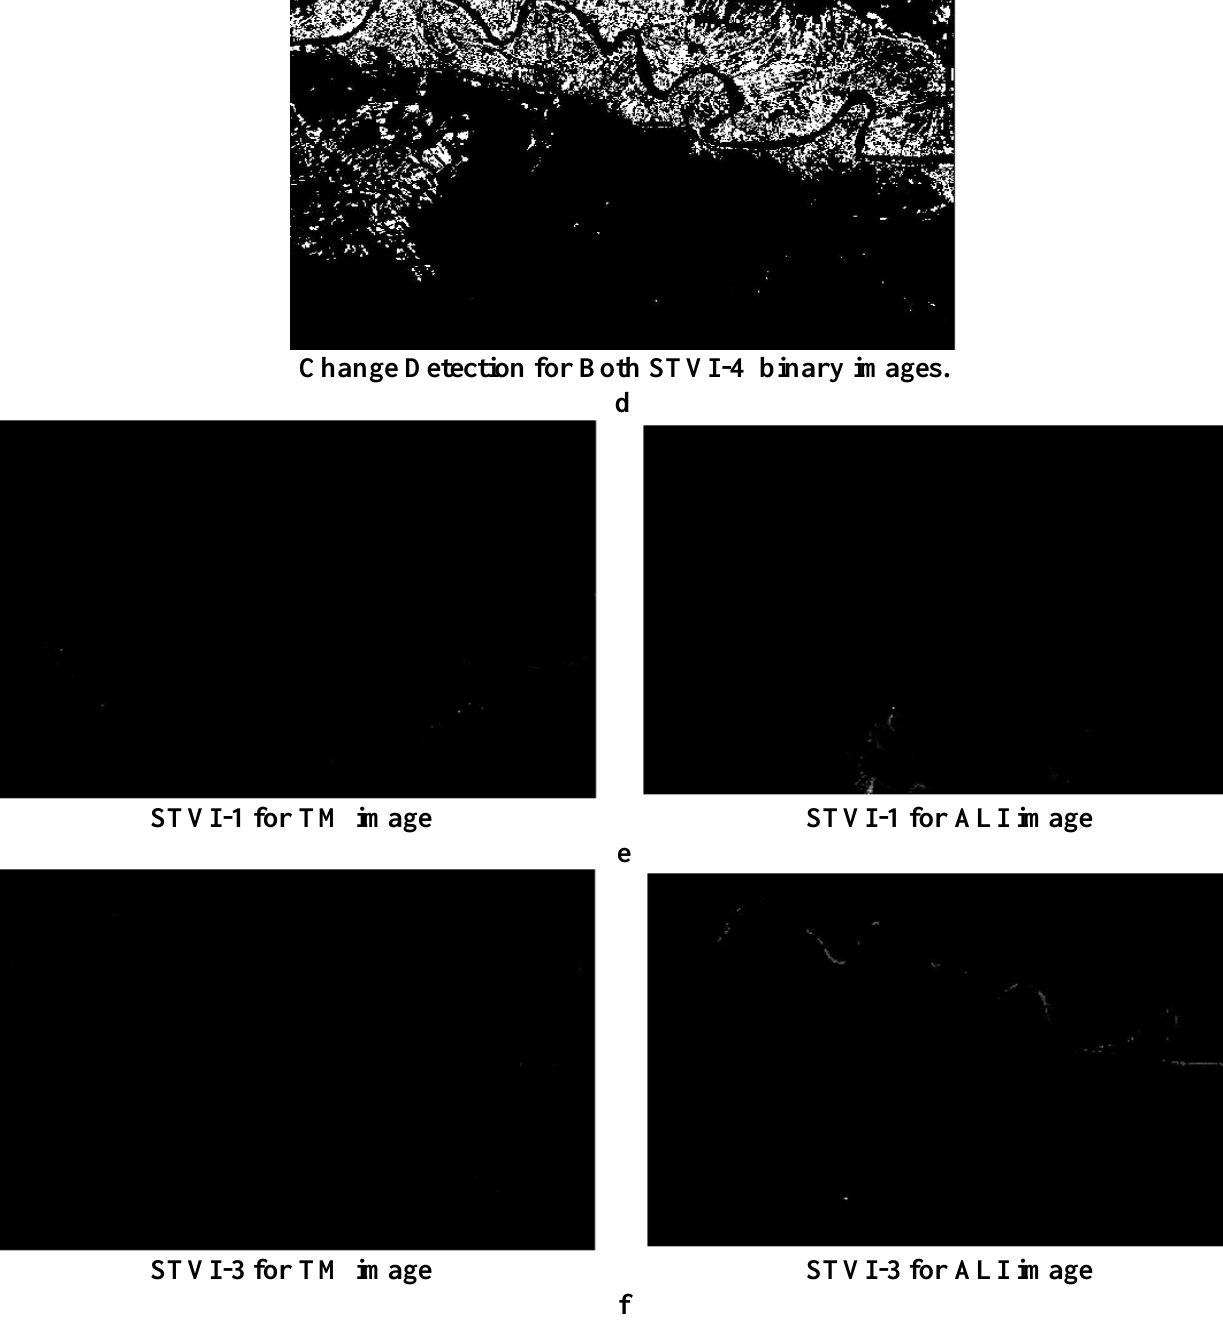
Fig.1: a- muilt-temporal a Ramadi city for landsat TM & Geo-Crrected EO-1 ALI, in years 1990, and 2003 (each of size 738 × 1027 Pixels), b, e, & f- the vegetation indices ( STVI-4, STVI-1 & STVI-3) effects on the multi- temporal images (1990 and 2003), c- vegetation layers, binaries by (decided threshold =185) for STVI-4 index, d- The changes in vegetation layers, using differencing images method between STVI-4 binaries